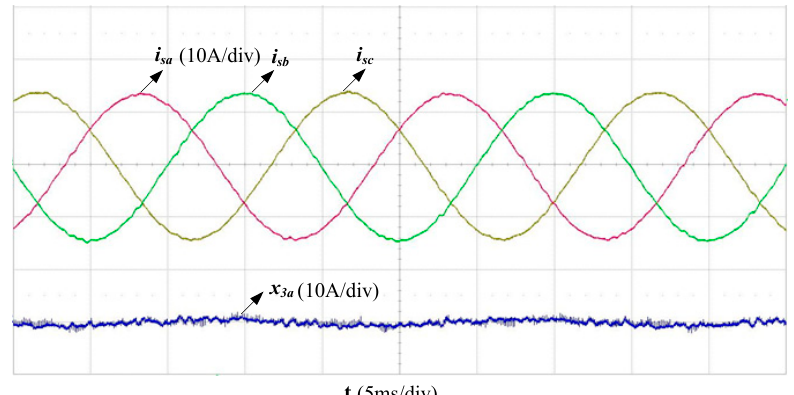
Figure 18. Experimental waveform of SAPF based on RCSMC after the filter inductor L 1 changes.